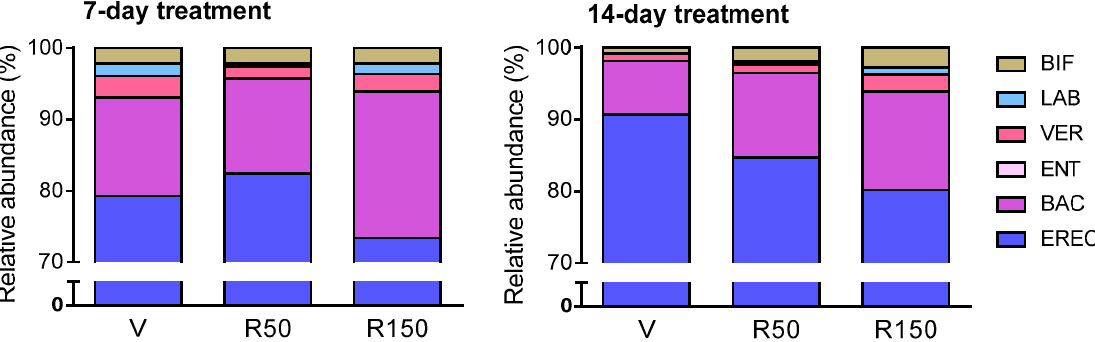
Figure 2. Relative distribution of the colonic microbiota, as quantified by FISH, in the different experimental groups. Data represent the relative abundance (percent) of the bacterial groups characterized [ Bacteroides spp. (BAC), Bifidobacterium spp. (BIF), Clostridium spp. (EREC), Enterobacteria (ENT), Lactobacillus spp. (LAB), and Verrucobacteria (VER)]. Relative percent composition of the microbiota was calculated taking as 100% the total counts of the bacterial groups assessed. n = 4–6 per group. V: Vehicle; R50: rifaximin at 50 mg/kg; R150: rifaximin at 150 mg/kg.